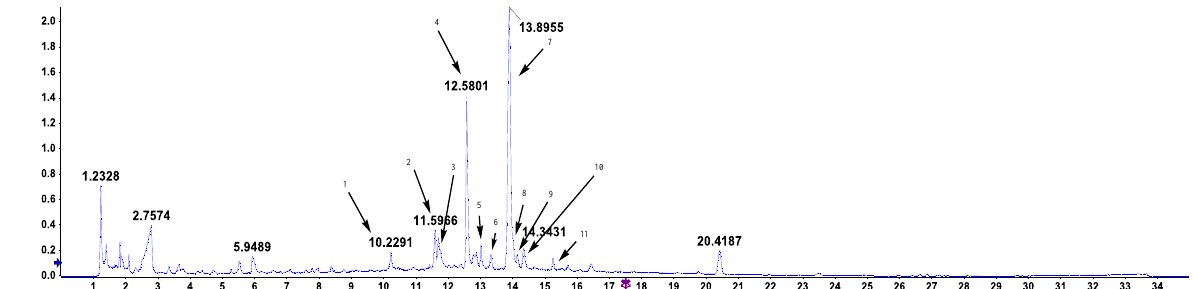
Figure 4. The UPLC chromatogram of flavonoid extraction from fig leaves detected at 254 nm.